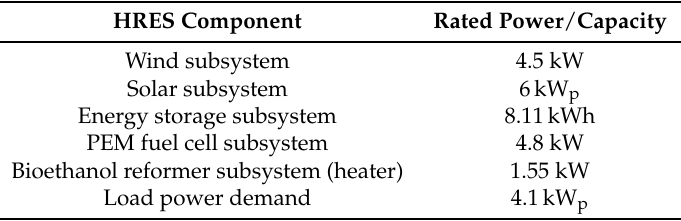
Table 1. HRES case study